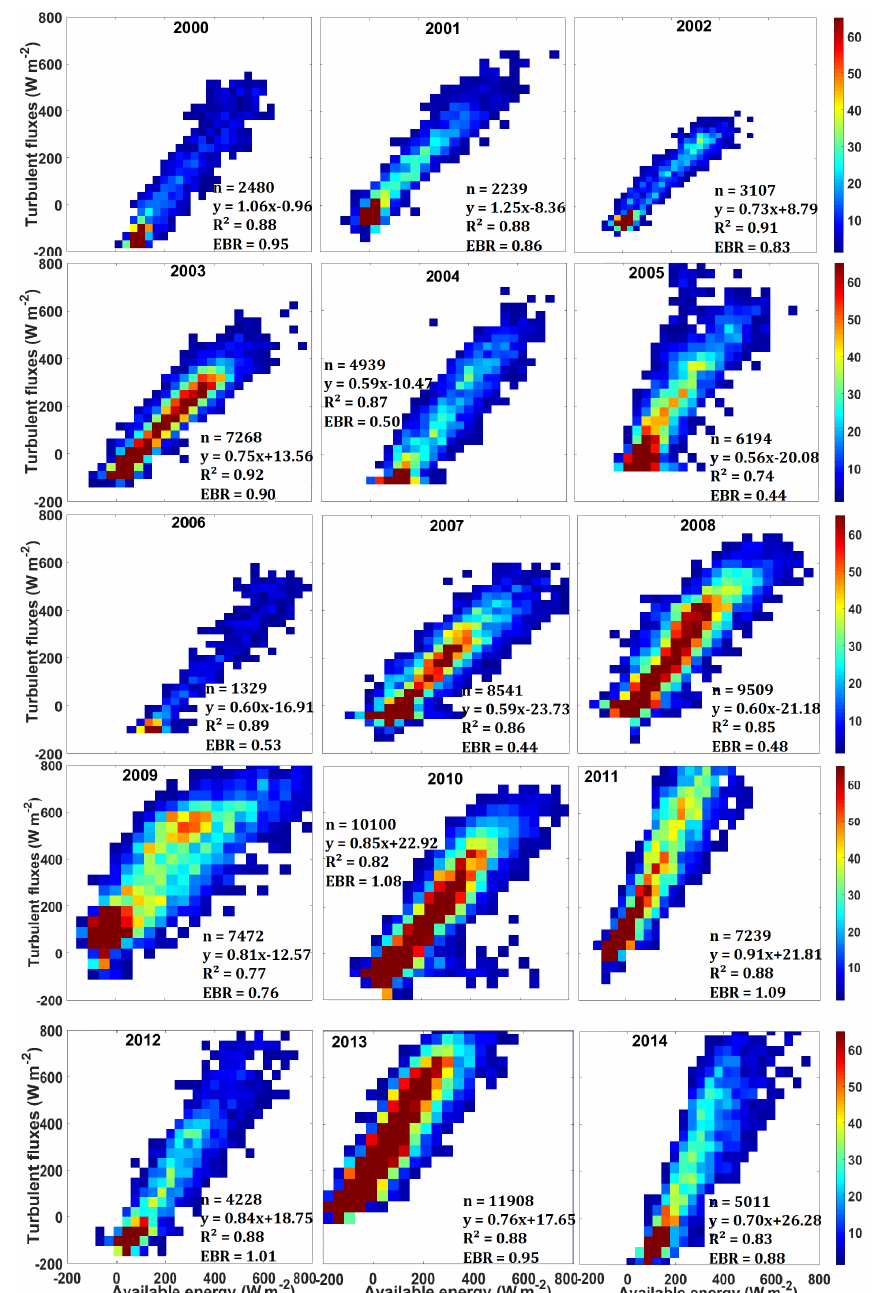
Figure 2. The 15-year series of annual regression analysis of turbulent (sensible and latent) heat fluxes against available energy (net radiation minus ground heat flux) from 2000 to 2014 at Skukuza (SA). The colour bars represent the count of EBR